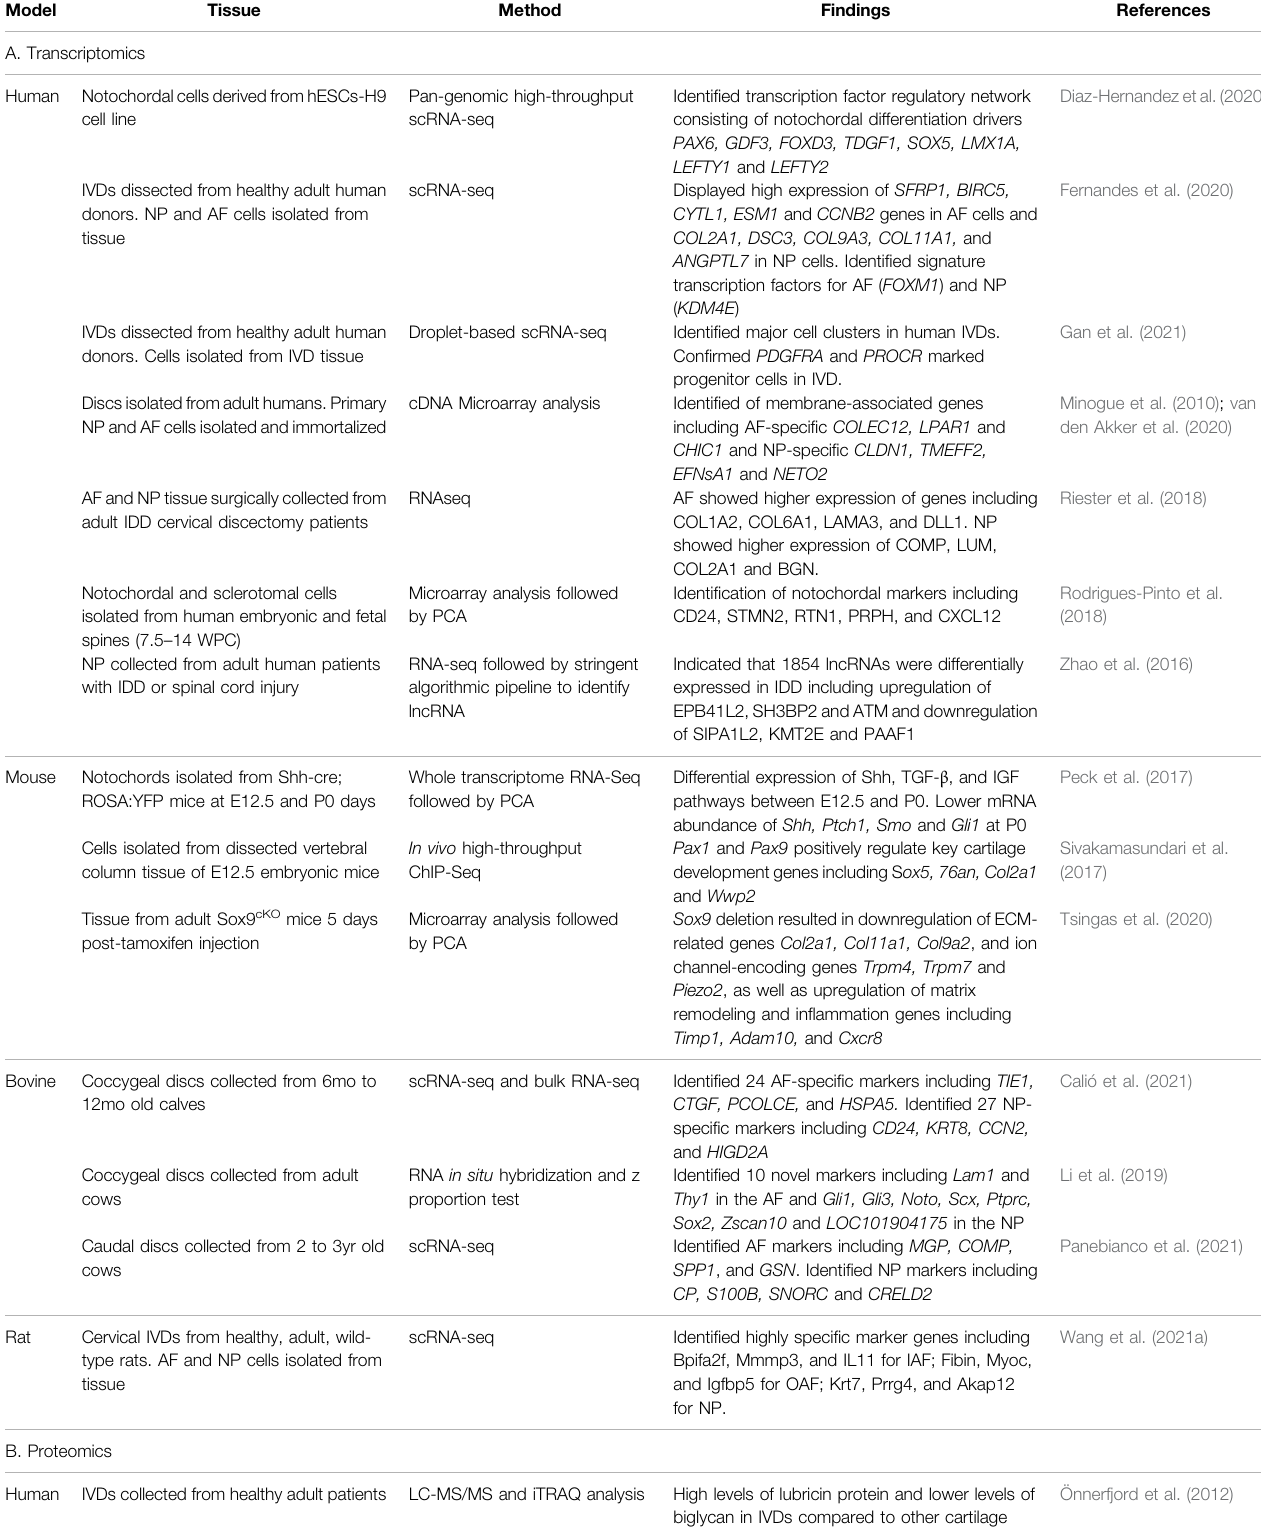
TABLE 3 | Summary of omics studies in IVD